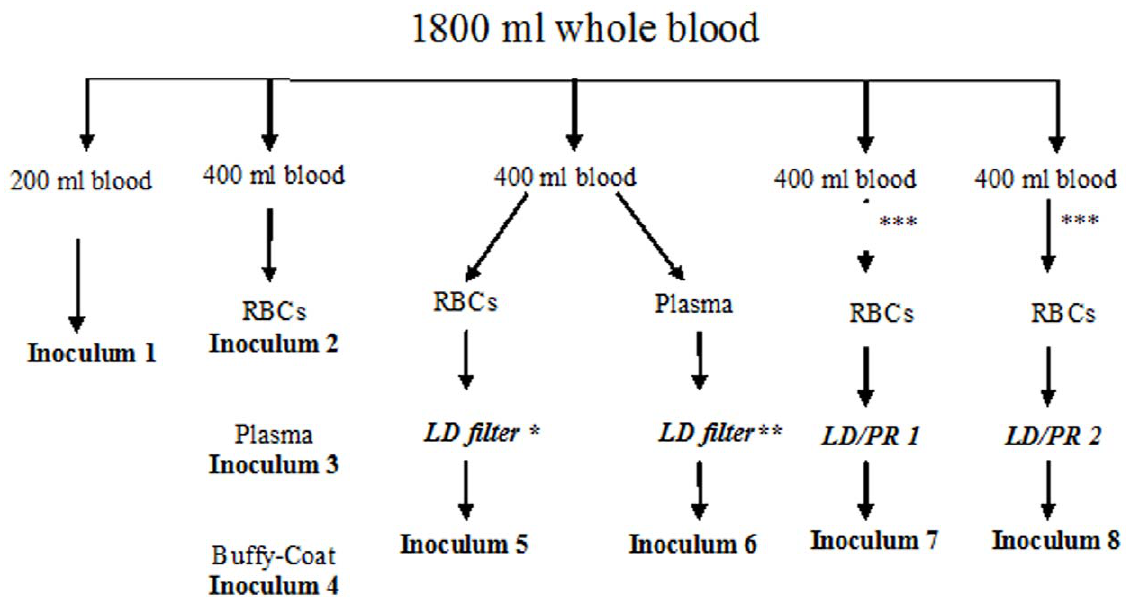
Figure 1. Design of blood products preparation and filtration process. 600 mL to 700 mL of whole blood were collected at the late stage of preclinical incubation from 15 VRQ/VRQ sheep orally inoculated with PG127 scrapie isolate. Blood from 3 sheep were pooled in a single pouch in order to obtain a volume higher than 1800 mL. Each pool was split into 5 parts that were individually processed according to the standard procedure applied in transfusion medicine. Obtained fractions were transfused or intravenously administered to TSE free VRQ/VRQ sheep, within five days following the blood collection. LD: leuco-depletion – LD/PR: leuco-depletion/Prion reduction. *:SEPACELL PURE RC (ASAHI). **: Plasma Filter Fenwal. ***: plasma for titration and cryoprecipitation